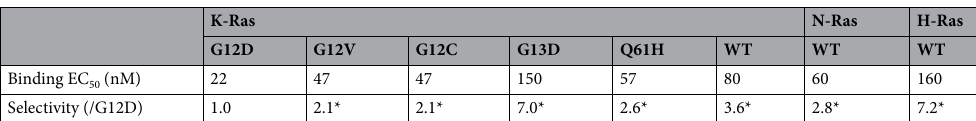
K-Ras N-Ras H-Ras G12D G12V